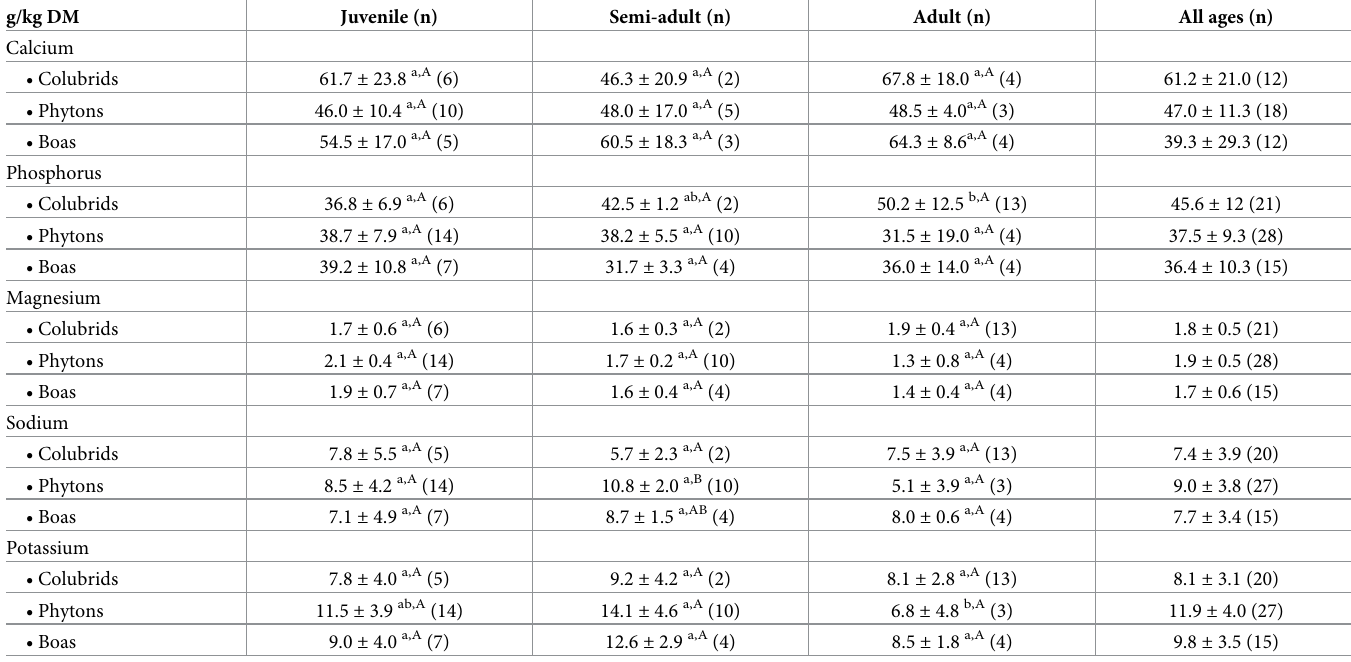
Table 4. Whole-body mineral content of snakes of the three species and age groups (means ± SD; n = number of samples; DM = dry matter).